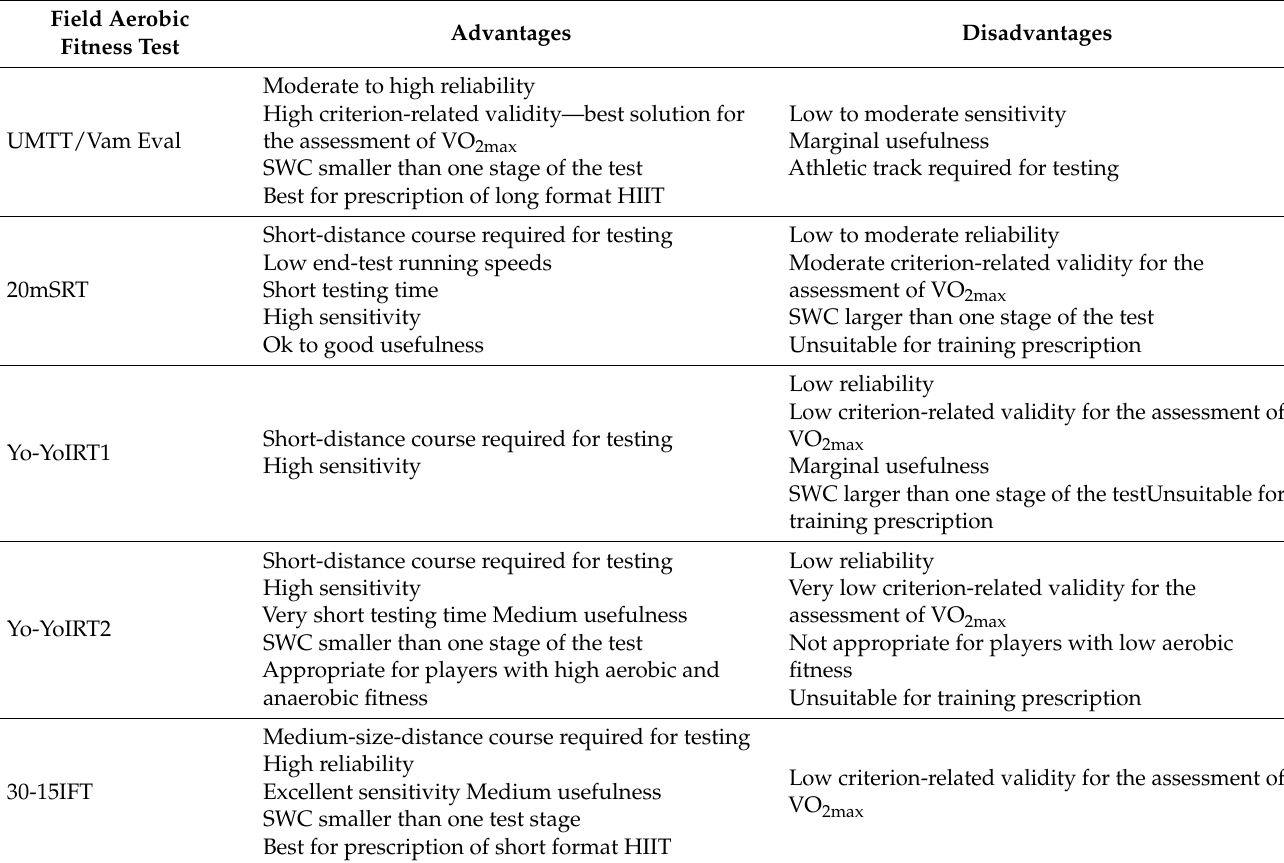
Table 6. Advantages and disadvantages of the reviewed field aerobic fitness tests. Field